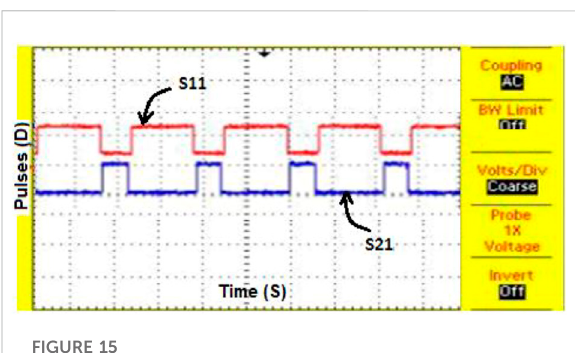
FIGURE 15 3D-SVPWM with NSV for switching pulse generation.